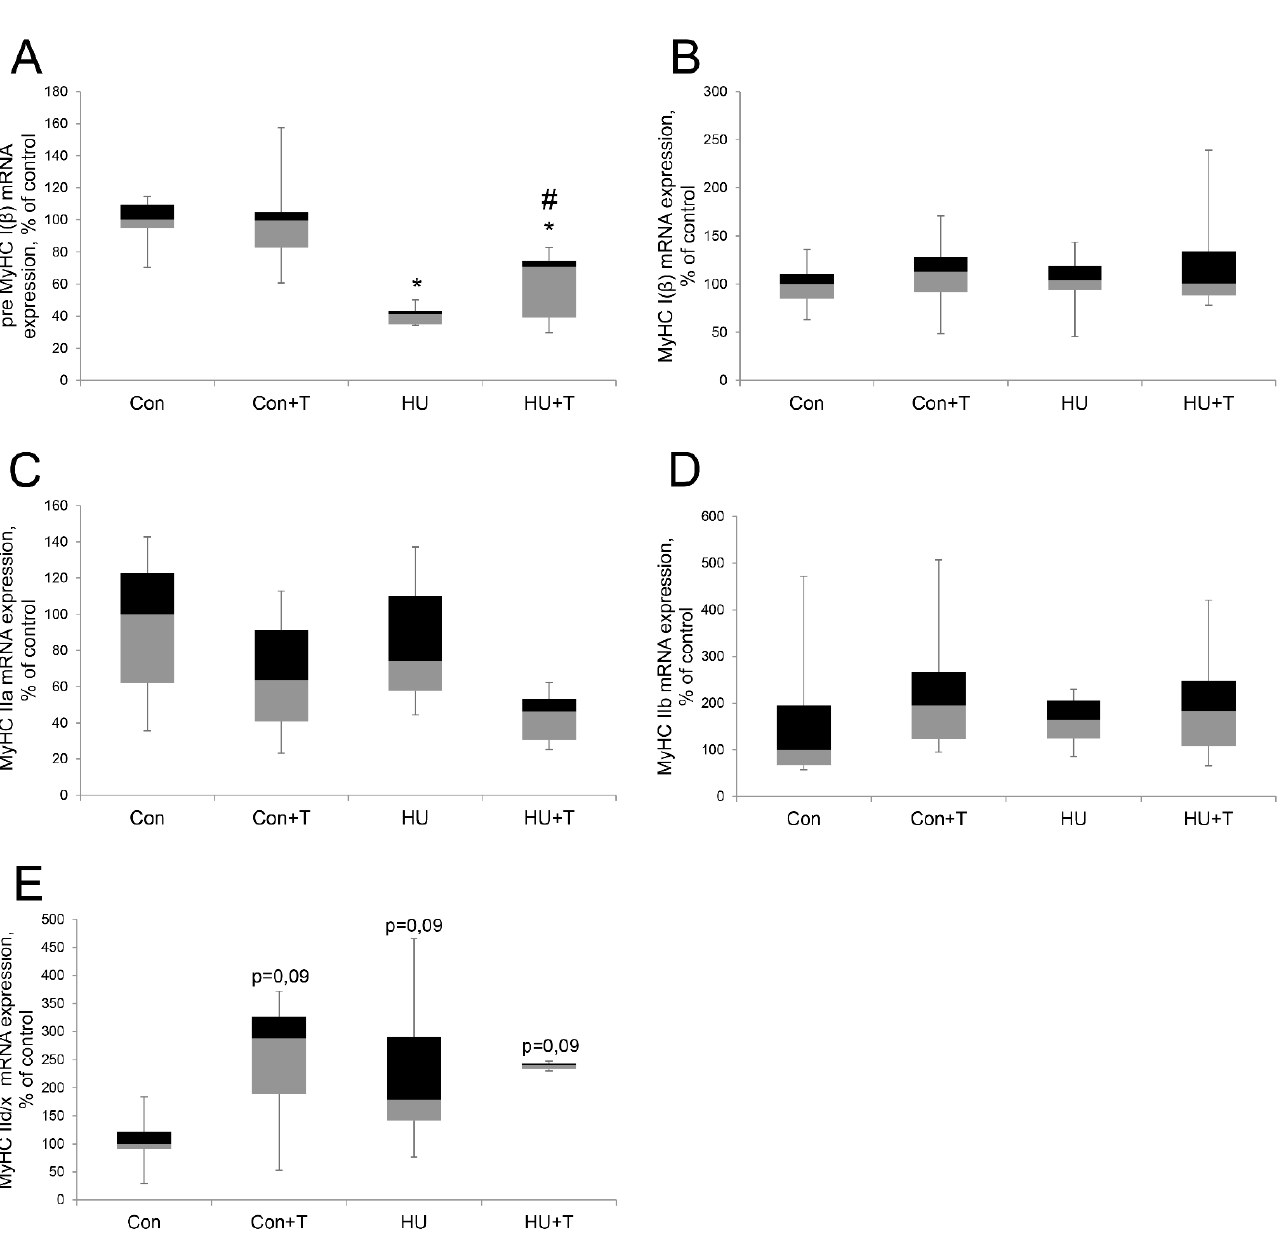
Figure 1. Expression levels of pre MyHC I( β ) ( A ) , MyHC I( β ) ( B ), MyHC IIa ( C ), MyHC IIb ( D ), MyHC IId/x ( E ), and mRNAs in rat soleus muscle in the control group (Con), control group with Tasquinimod treatment (Con + T), 24 h of hindlimb unloading via hindlimb suspension (HU), 24 h of hindlimb unloading via hindlimb suspension with Tasquinimod treatment (HU + T). Data are shown as % of the control group. *—significant difference from the control group. #—significant difference from HU group ( p < 0.05). Box plots show 25–75 percentiles and median values and the whiskers represent the minimum and the maximum; n =